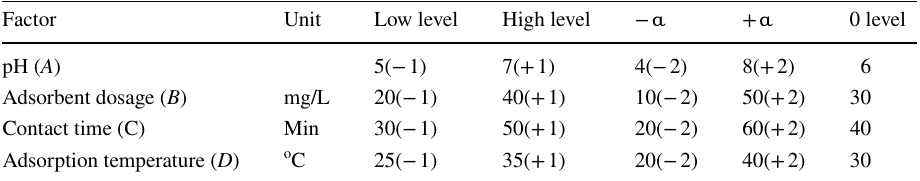
factor in actual and coded form for adsorption of fibre cement industry effluent using coal- based activated